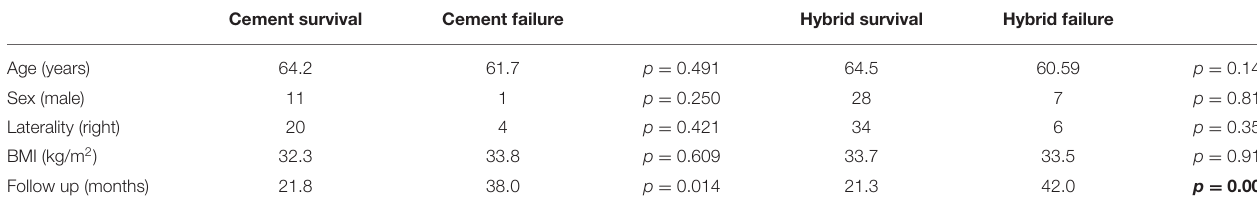
TABLE 2 | Mean patient demographics for survival vs failure in cemented and hybrid cohorts.